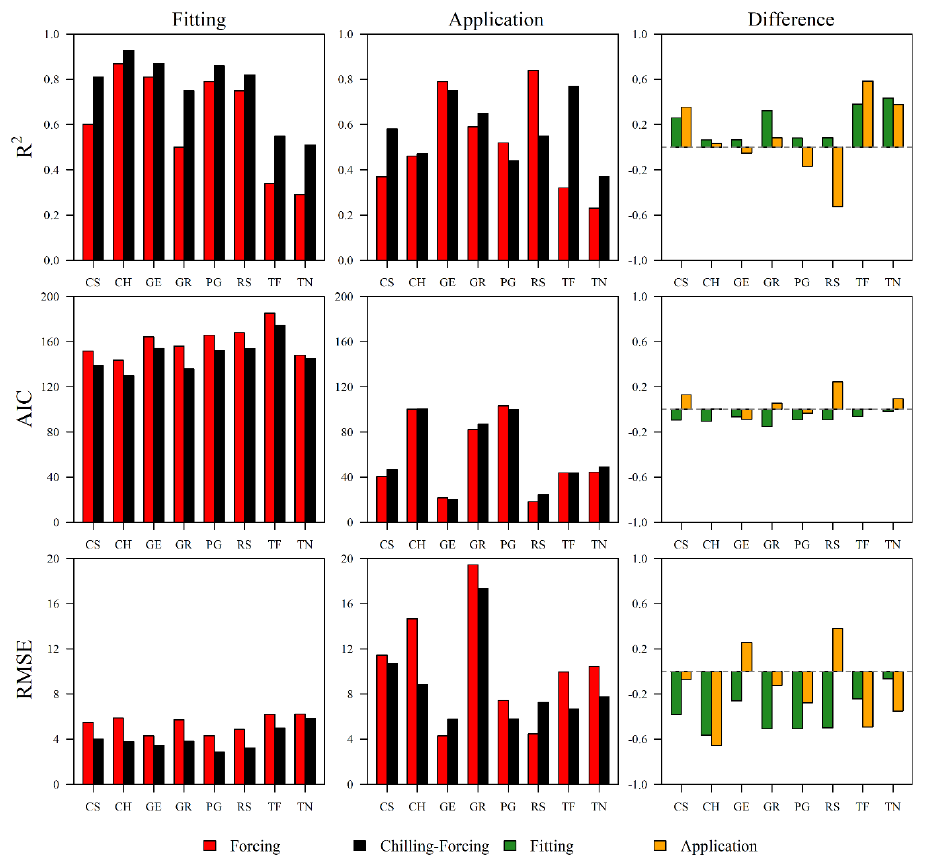
Figure 6. Statistical results (R 2 , AIC and RMSE) of the comparison between CF (black bars) and F (red bars) approaches in model fitting and application for all grapevine varieties using HP parameter set. The differences between CF and F models (CF-F) in both fitting and applications are displayed using green and yellow bars, respectively. CS = Cabernet Sauvignon, CH = Chardonnay, GE = Gewürztraminer, GR = Grenache, PG = Pinot Gris, RS = Riesling, TF = Touriga Franca, TN = Touriga